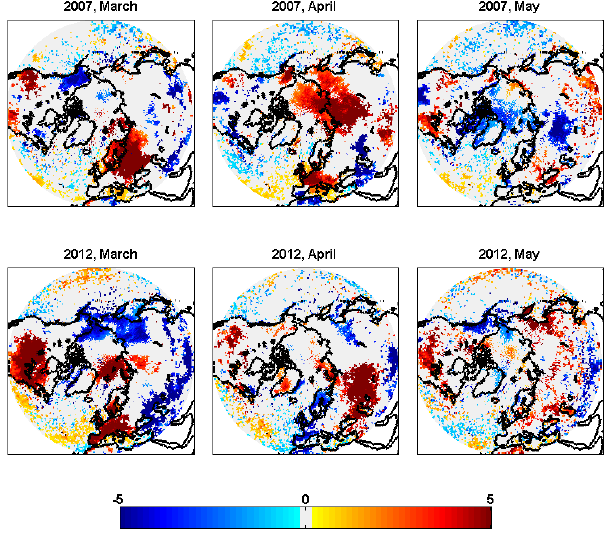
Fig. 5. Surface skin temperature [K] anomalies for the MAM Fig. 5: Surface skin temperature [K] anomalies for the MAM months of 2007 (top row) months of 2007 (top row) and 2012 (bottom row). and 2012 (bottom row).